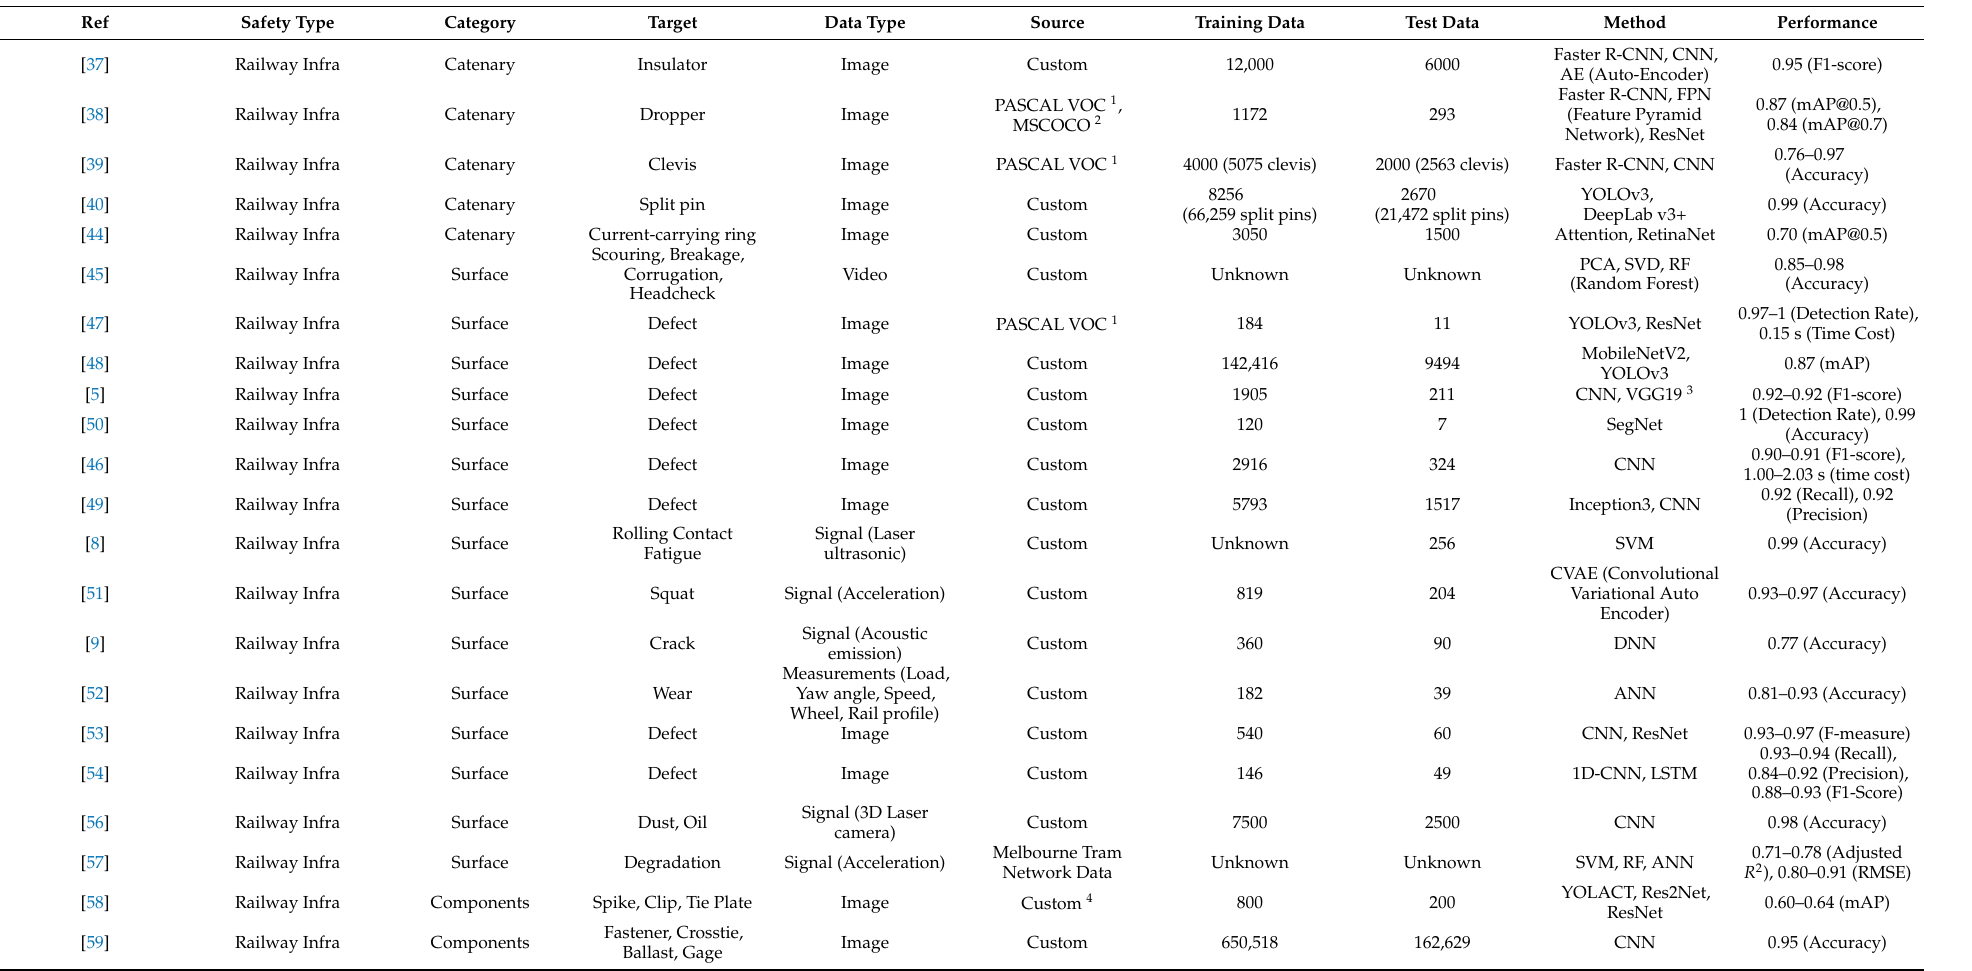
Table A1. Studies of AI applications for railway